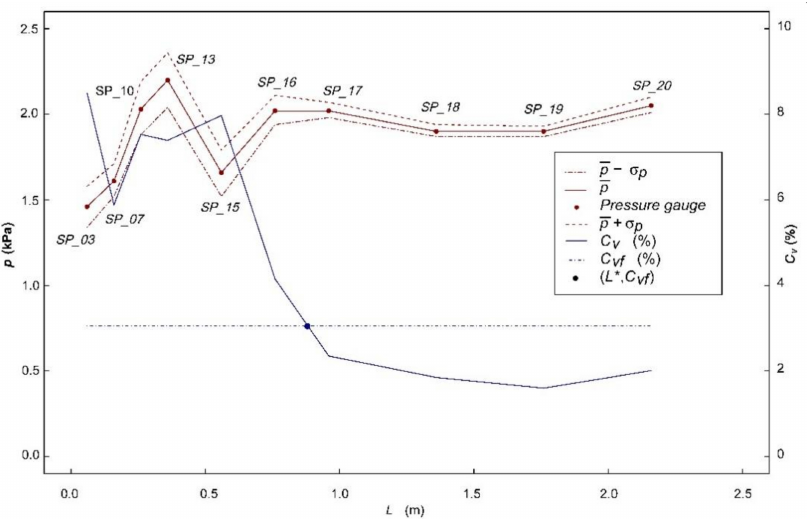
Figure 6. Example of the determination of the required length of the HCCs basin ( L* ) in phase 3 tests. The figure shows the results obtained from the measurements of the dynamic pressure gauges located in the longitudinal axis of the basin: mean dynamic pressure ( p ), standard deviation ( σ p ), and coefficient of variation ( C V